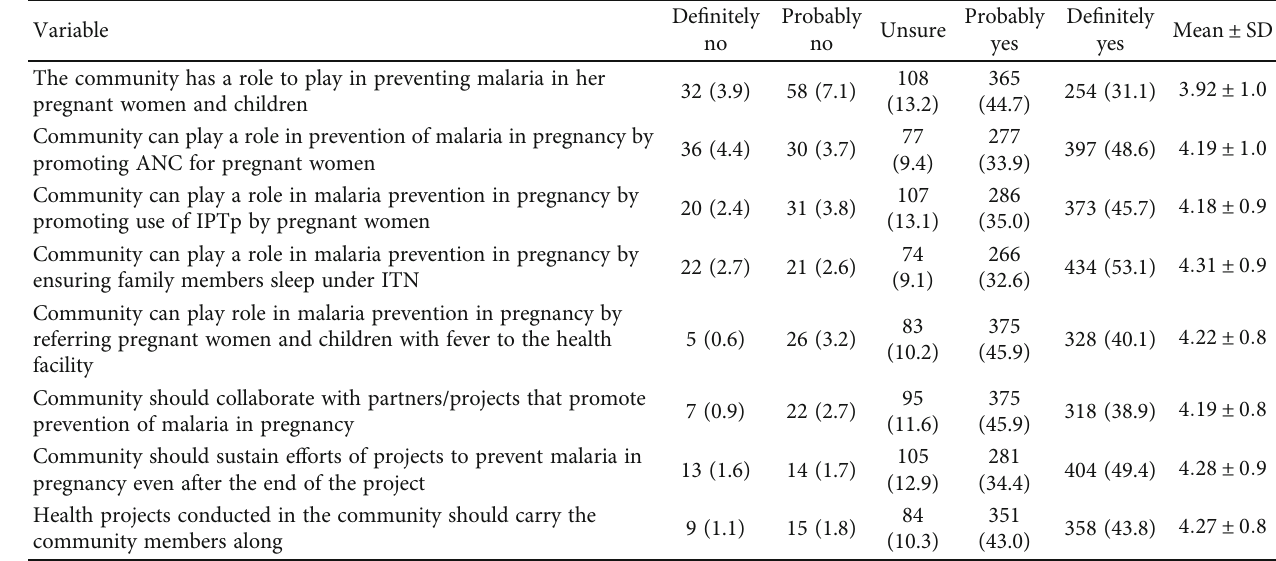
Table 5: Perceived community roles in prevention of malaria in pregnancy and childhood among community members in Ebonyi, Nigeria ( n = 817